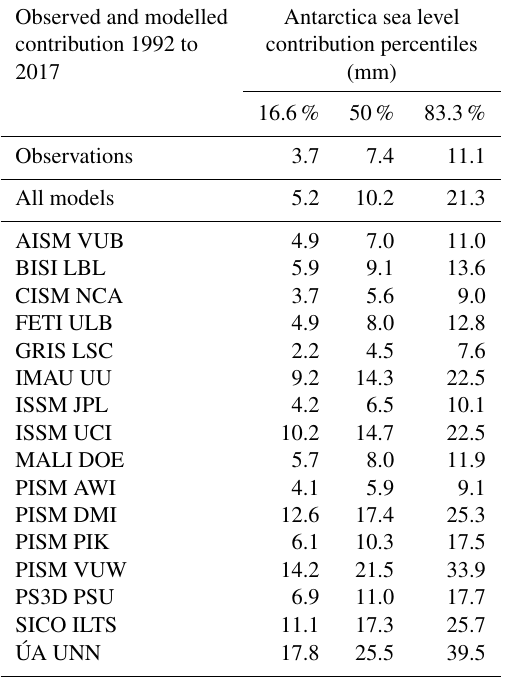
Table 6. Likely hindcast range of historical sea level contribution compared to the observed range.